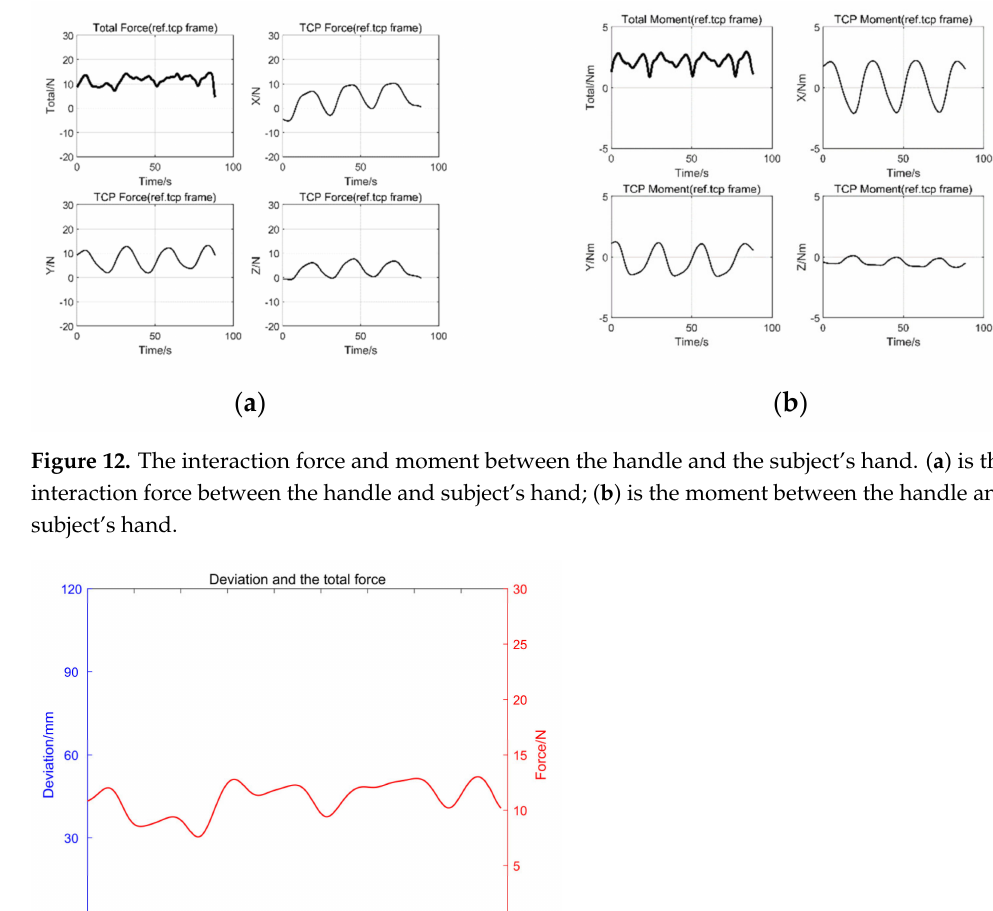
Figure 11. The trajectory of the subject’s arm during the passive testing. ( a ) Three-dimensional view of the trajectory; ( b – d ) XOY, XOZ, and YOZ view of the trajectory, respectively.